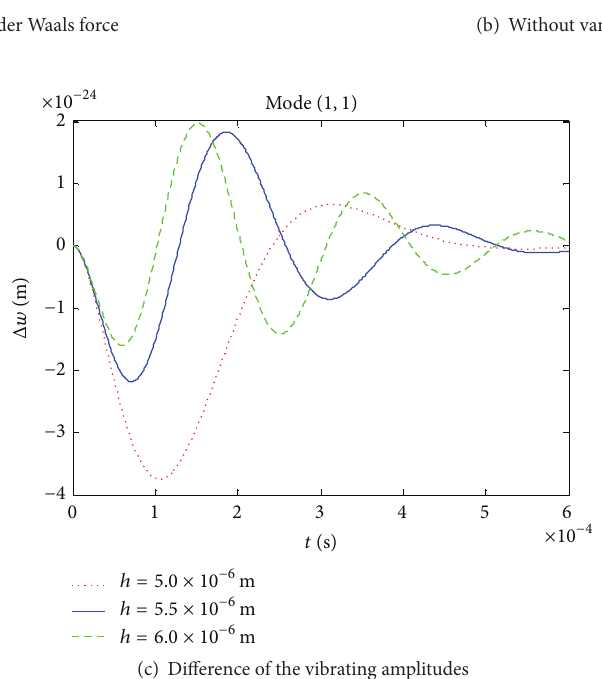
when the van der Waals force is considered. As the thickness ℎ of the micro film grows, the effects of the van der Waals force on the vibrating amplitudes of the film center first become small and then become large. (4) As the initial tension stress of the micro film grows, the vibrating amplitudes of the film center drop more slowly with time. When the van der Waals force is not considered, the vibrating amplitudes of the film center drop first more